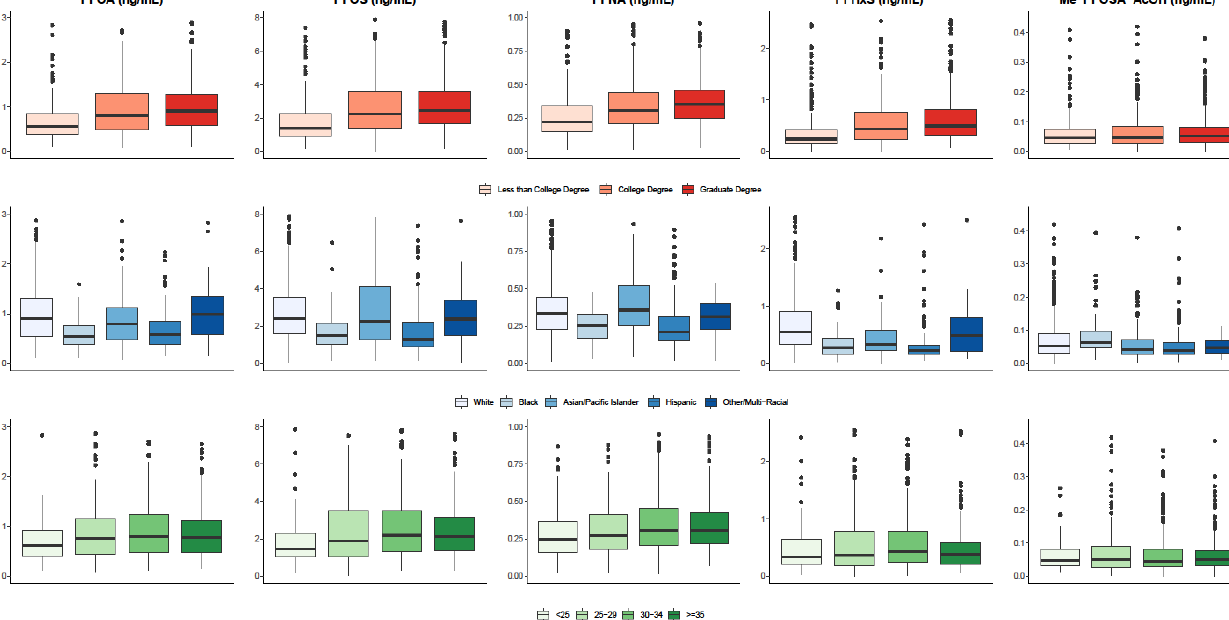
Figure 1. Distribution of polyfluoroalkyl substances (PFAS) (ng/mL) levels with >75% detection stratified by cohort.